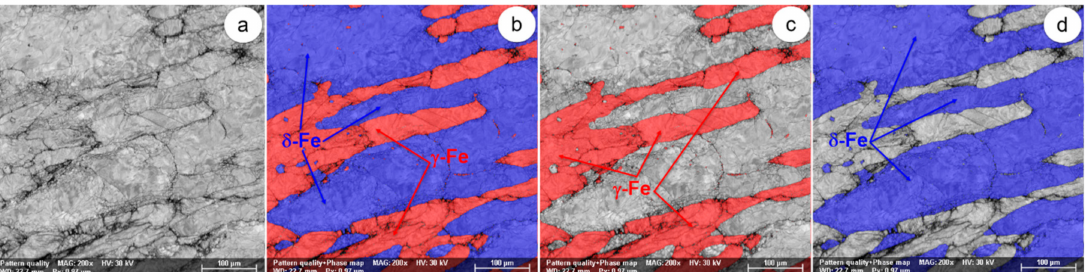
Figure 17. The SEM-EBSD composite images ( × 200) obtained after forging at 1200 ◦ C: ( a ) the microstructure of the analysed field; ( b ) the distribution of existing phases in the microstructure of the analysed field; ( c ) the distribution of the γ -Fe phase; ( d ) the distribution of the δ -Fe phase.